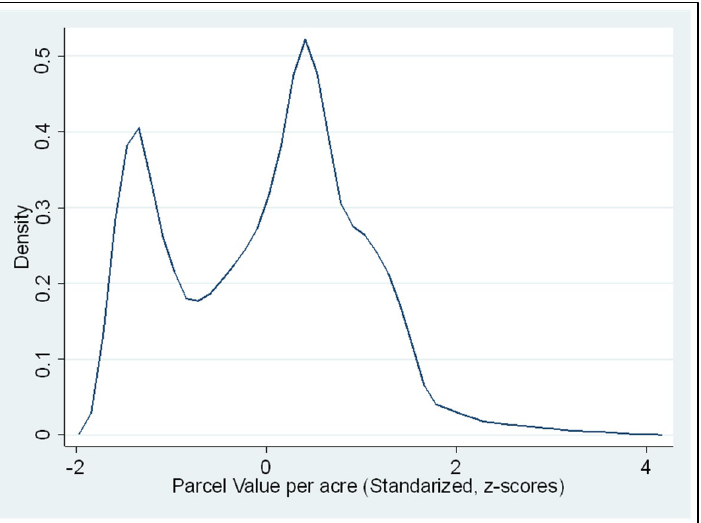
Figure 3. Distribution of standardized land value per acre: kernel density estimation. Notes: It provides the distribution of parcel value per acre (in standardized z-scores) to investigate the effect of outliers on the land value. The result of a separate estimation not including those outliers confirms that property values in the region are substantially affected by proximity to local markets. Table 4. Robustness check: IV estimates of the effect of proximity to ethanol plants on farmland values (USD/acre).